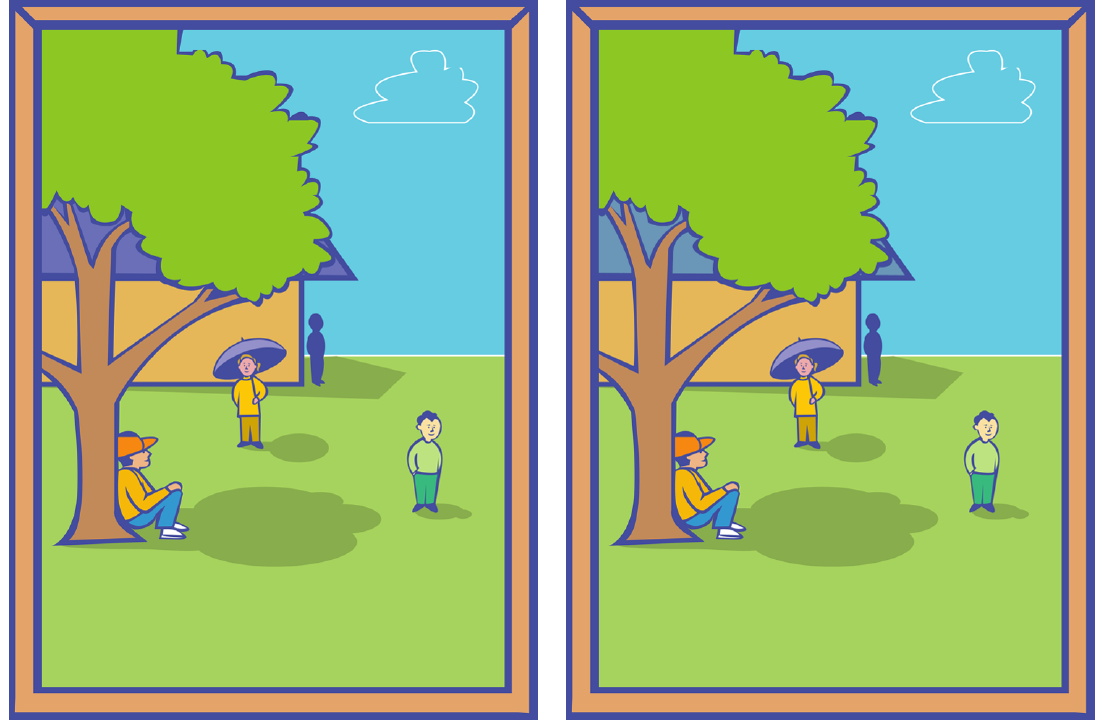
Figure 1. Example of change blindness-inducing image